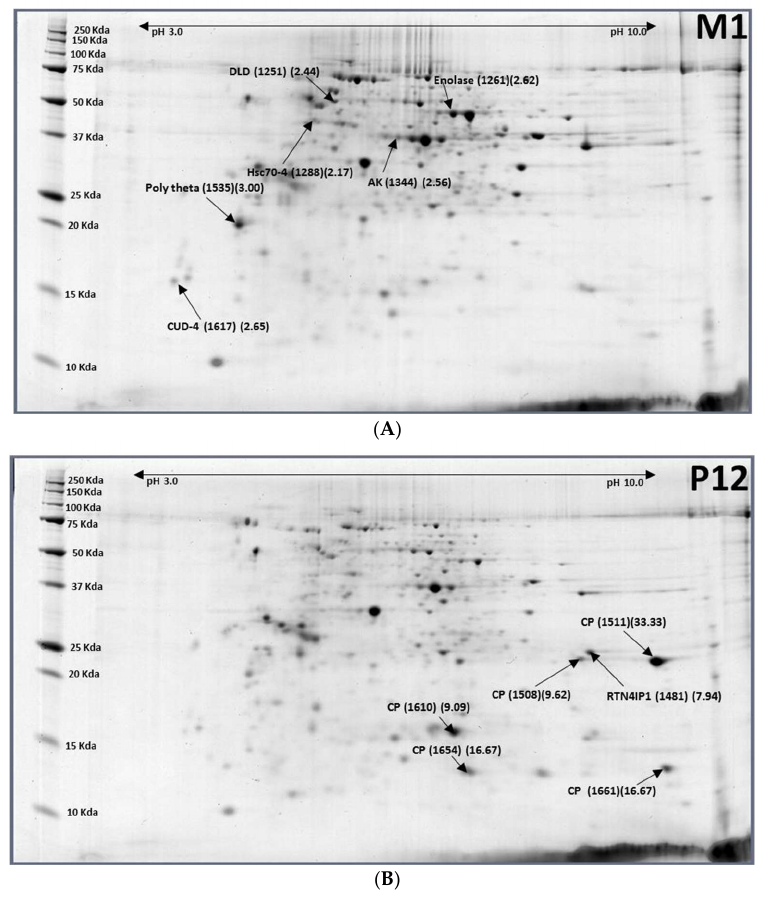
Figure 4. Representative images of 1-day-old males ( A ) and 12-day-old pupae ( B ) of Bactrocera latifrons . Images were labelled with protein names (spot ID#) (M1/P12 ratios). Table 4. Differentially expressed proteins between 12-day-old pupae and 1-day-old males of Bactrocera